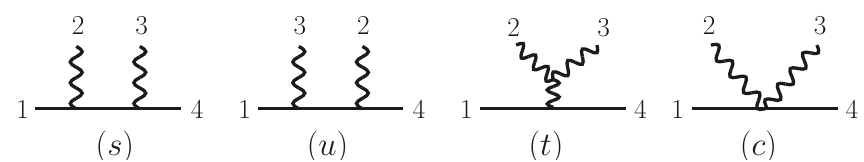
Figure 10 . Feynman diagrams for the four-point amplitudes. Absorbing the four-point contact term ( c ) into diagrams ( s ), ( t ), and ( u ) gives a BCJ representation of the